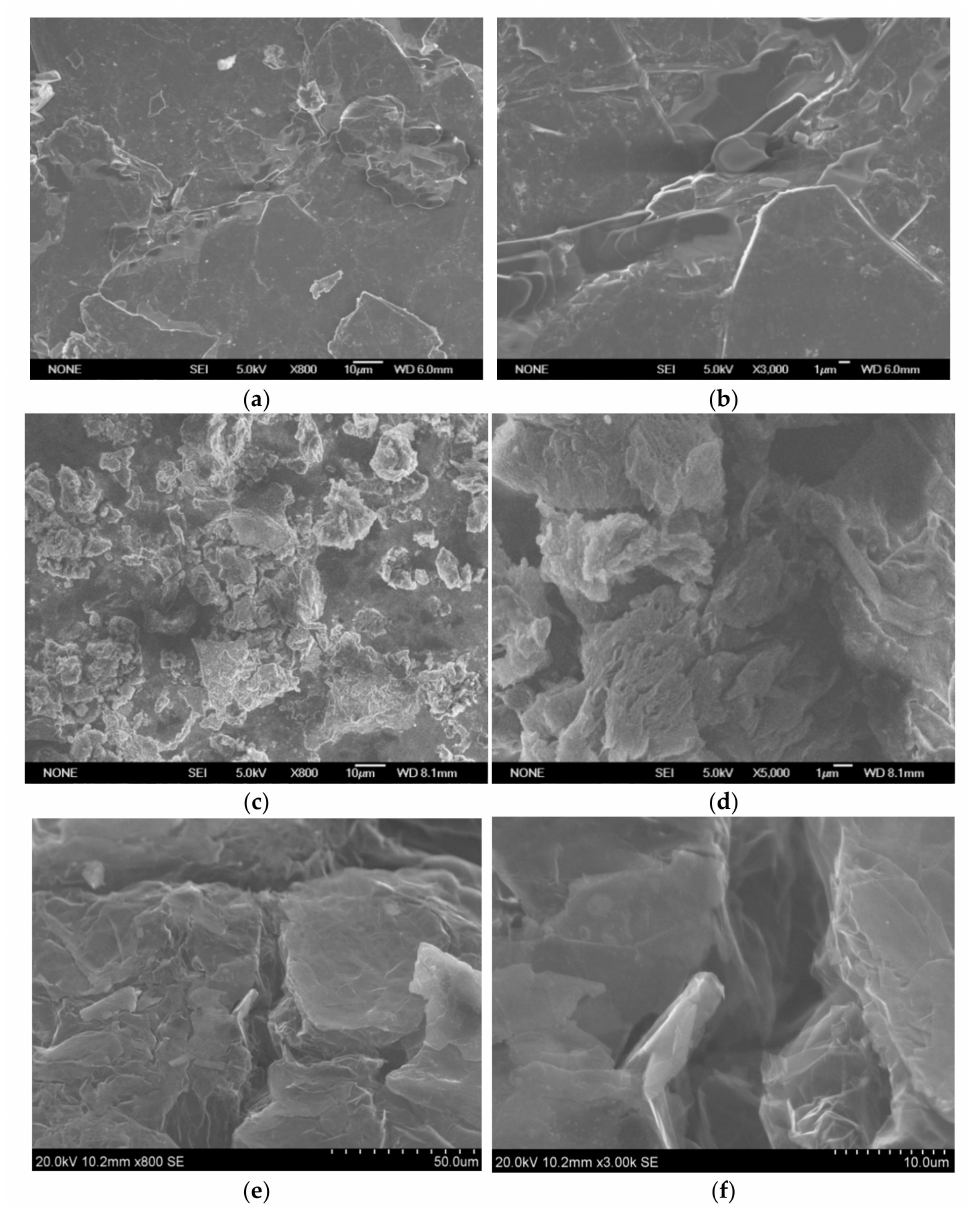
Figure 3. SEM images of the samples: ( a , b )–intercalated graphite; ( c , d )–TEG1-400 sample, obtained by programmable heating; ( e , f )–TEG2-400 sample, obtained by thermal shock. Table 3. Yield, bulk density, and textural characteristics of samples synthesized by programmable heating and thermal